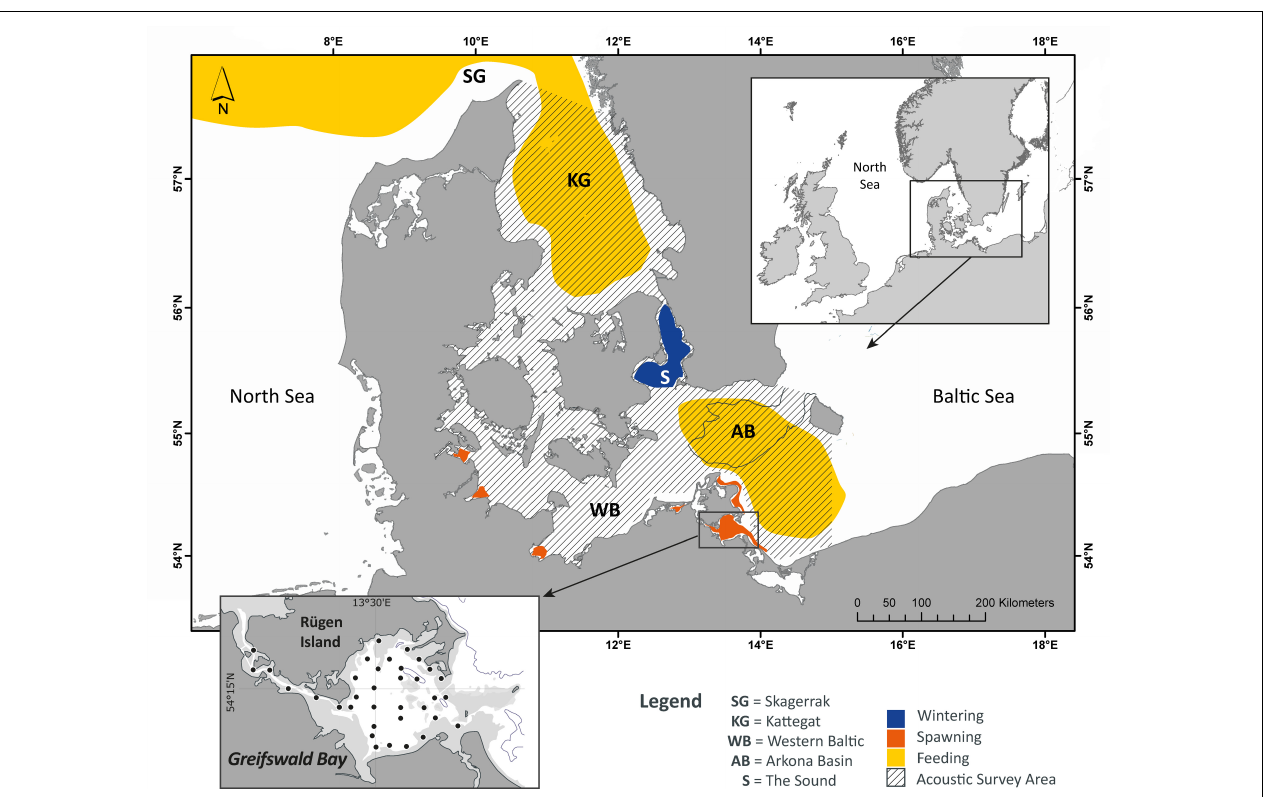
FIGURE 1 | Study area, including the sampling area of the German acoustic survey (GERAS) in the western Baltic Sea (gray shading) and the sampling stations of the Rügen herring larvae survey (black dots) in Greifswald Bay. Spawning sites are not considered exclusive but represent the current state of